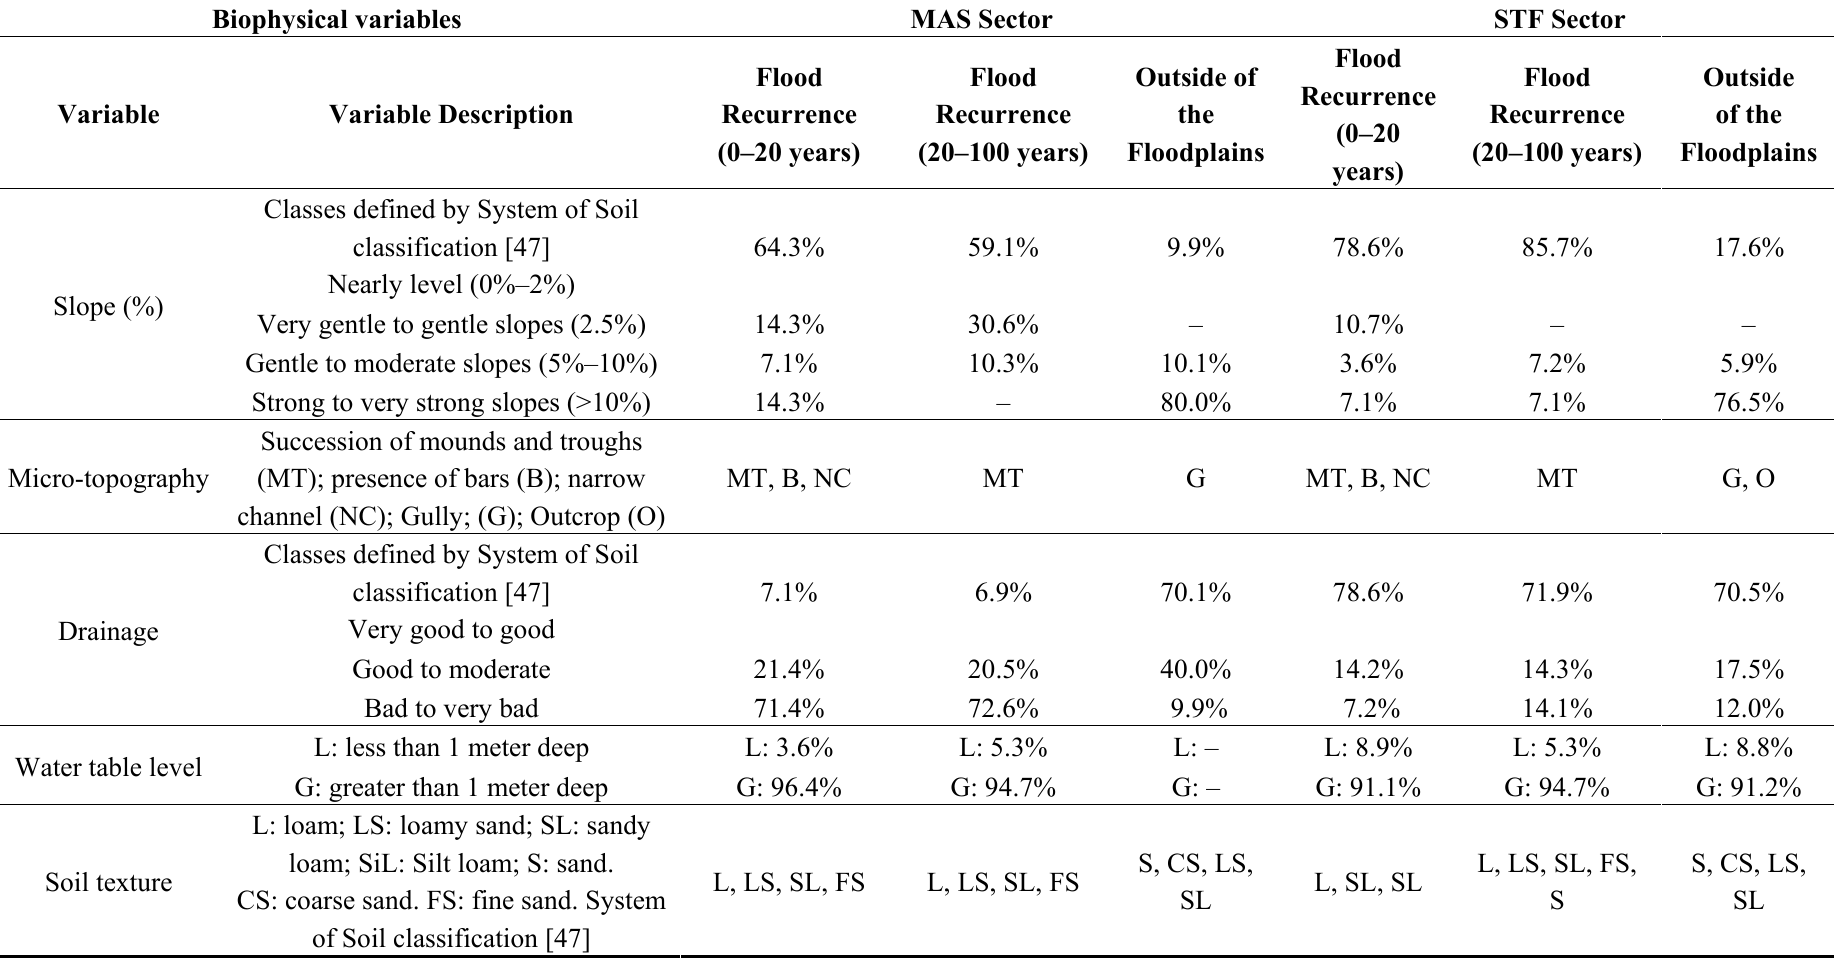
Table 2. Biophysical variables measured in the quadrats (94 in total) in different flood zones and no-flood zones along the Massawippi (MAS) and Saint-François (STF) rivers in southern Québec,